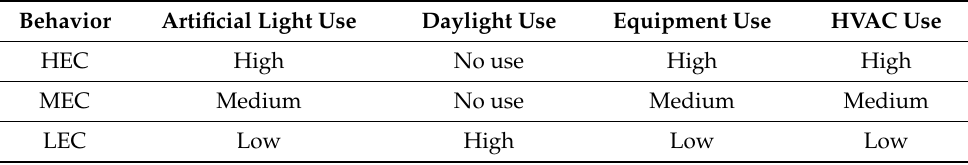
Table 1. Behavior assumptions according to the use of energy